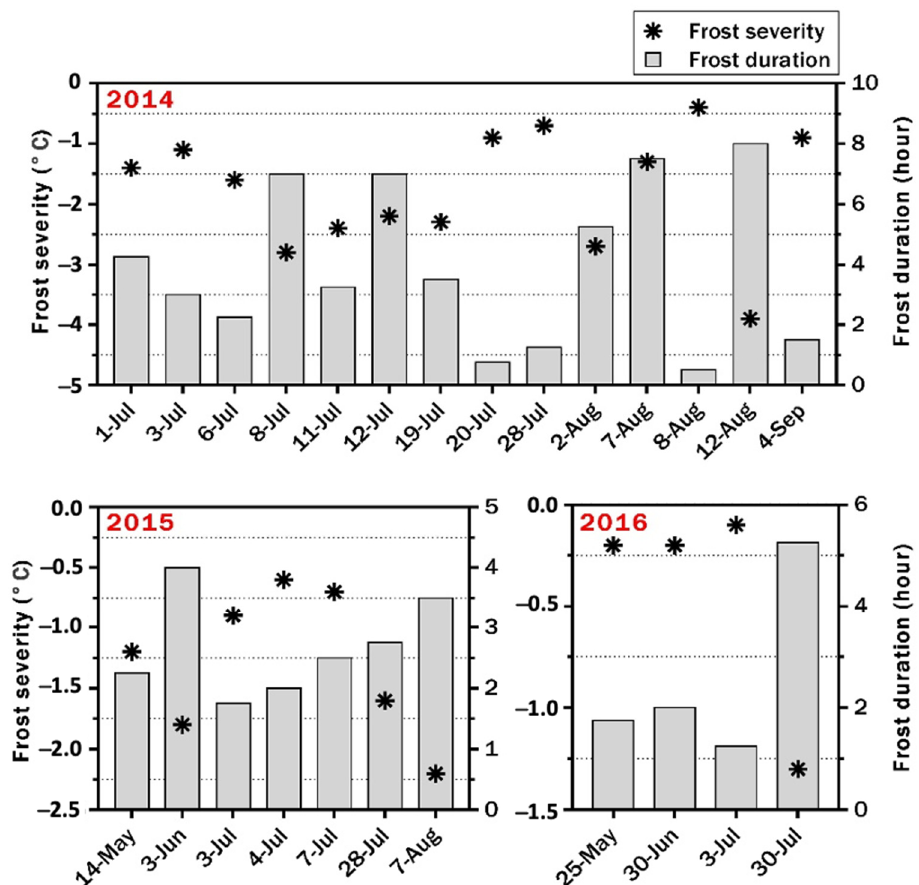
Figure 2. The severity and duration of frost events during the 2014, 2015, and 2016 growing seasons at the University of Sydney at Narrabri.